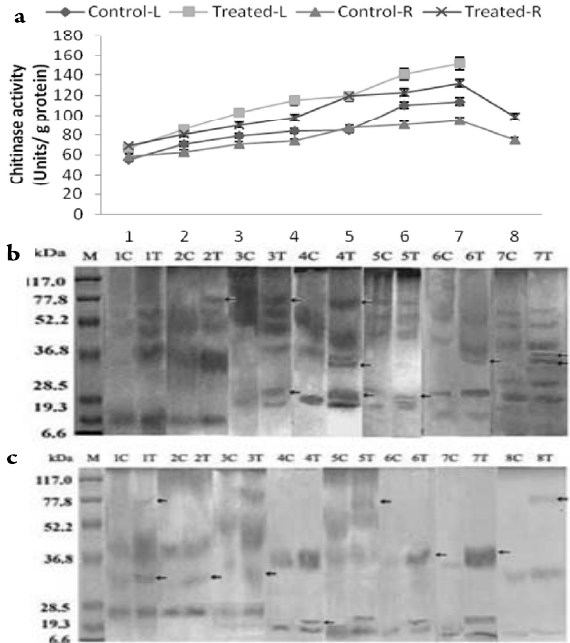
Fig. 1. Chitinase activity (a) in control and treated turmeric plants (L- Leaf; R- Rhizome); Localization of chitinase isoforms in leaves (b) and rhizomes (c) of turmeric plants on SDS-PAGE (10%) M - Marker protein standard (Bio Rad Chem. Co., USA); C - Control; T - Treated; 1 to 8 - age of the plant in month. Molecular weight of marker protein: 117.0 kDa- β -Galactosidase; 77.8 kDa- BSA; 52.2 kDa- Ovalbumin; 36.8 kDa-